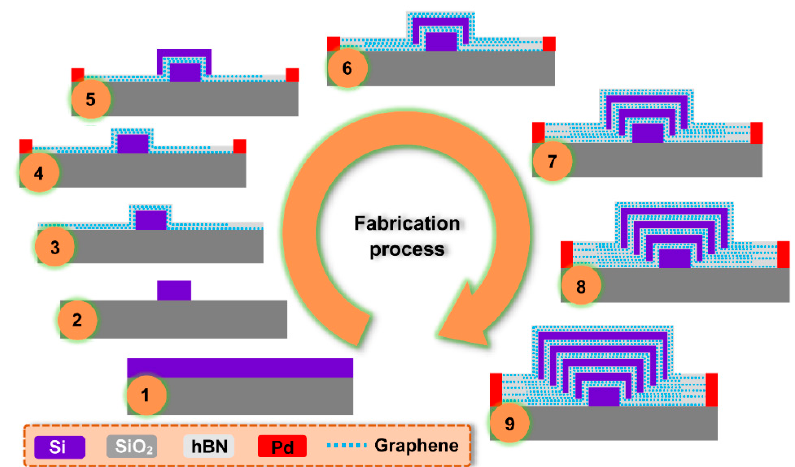
Figure 7. Fabrication process of the proposed hybrid graphene-silicon-based polarization-insensitive EAM. Starting from a silicon-on-insulator (SOI) wafer (step 1) and then etching to form the bottom silicon nanowire (step 2). The hBN-graphene-hBN-graphene-hBN heterostructure is further deposited on the bottom silicon nanowire (step 3), and the effective metal contacts on both sides of the waveguide are also done (step 4). The second silicon nanowire is grown on the first hybrid graphene-silicon waveguide layer (step 5), and the hBN-graphene-hBN-graphene-hBN heterostructure is also deposited, including the metal contacts (step 6). Using the same method to fabricate the third to the fifth hybrid graphene-silicon waveguide layers consecutively (step 7 to step 9). Note that for clarity, the silicon substrate of the SOI wafer is not shown.